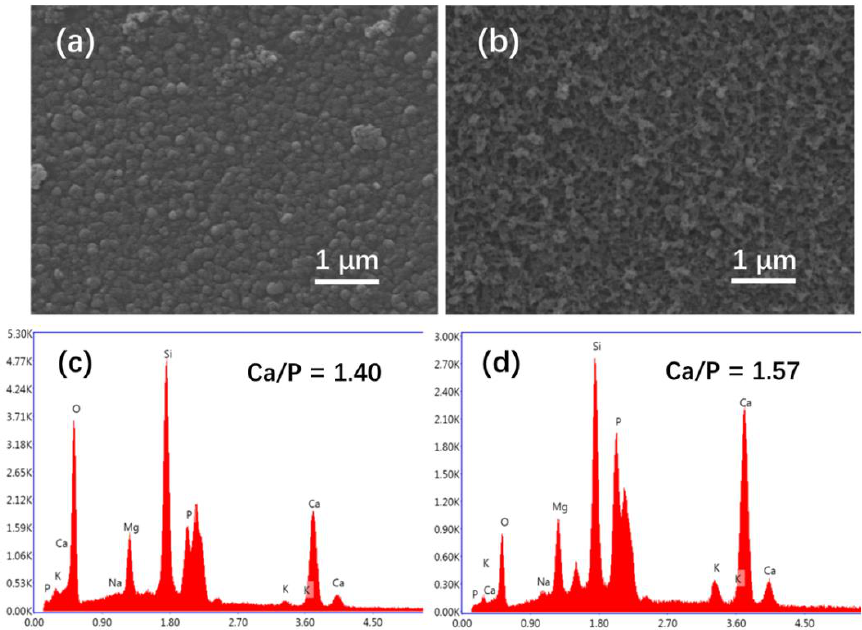
Figure 14. SEM image of the glass samples immersed in SBF for 6 days ( a ) without and ( b ) with a DC electric field; EDS analysis for the glass samples immersed in SBF for 6 days ( c ) without and ( d ) with a DC electric field.